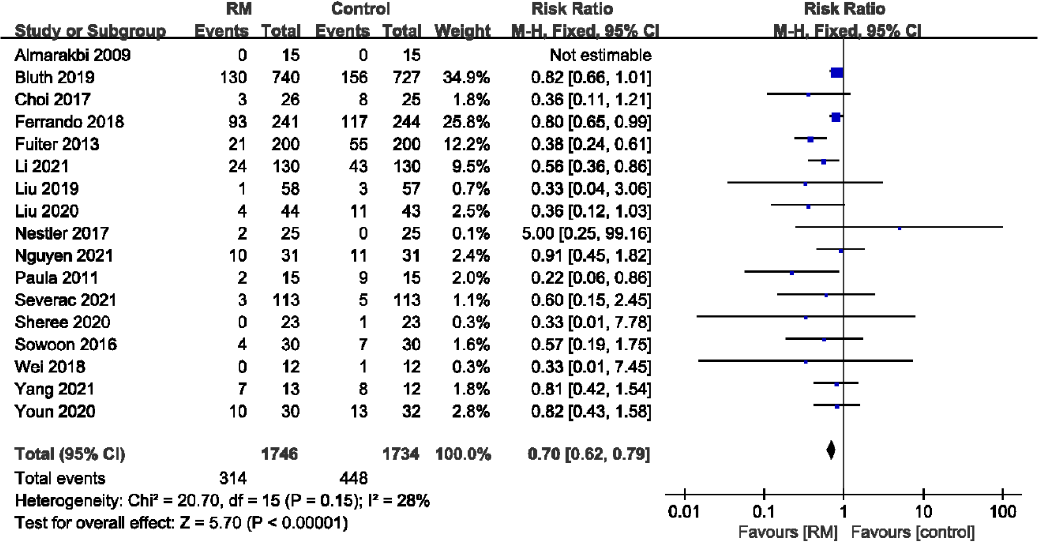
Figure 3. Forest plot for the incidence of PPCs between RM and control groups [16 – 32].